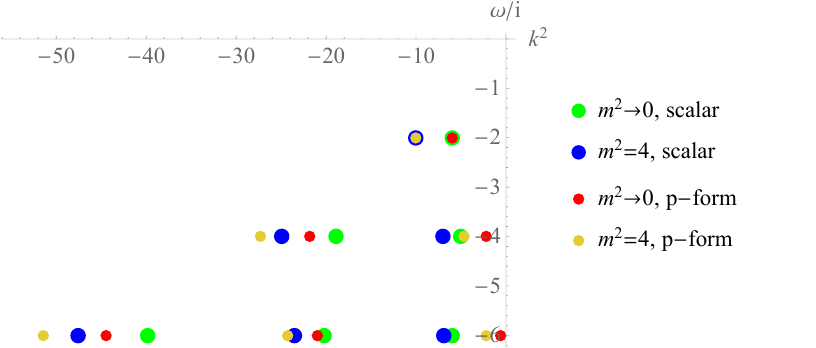
Figure 3 . Scatter diagram for the massive temporal mode. The background spacetime is set as AdS ( d = 3) ; the radius is fixed as r 5